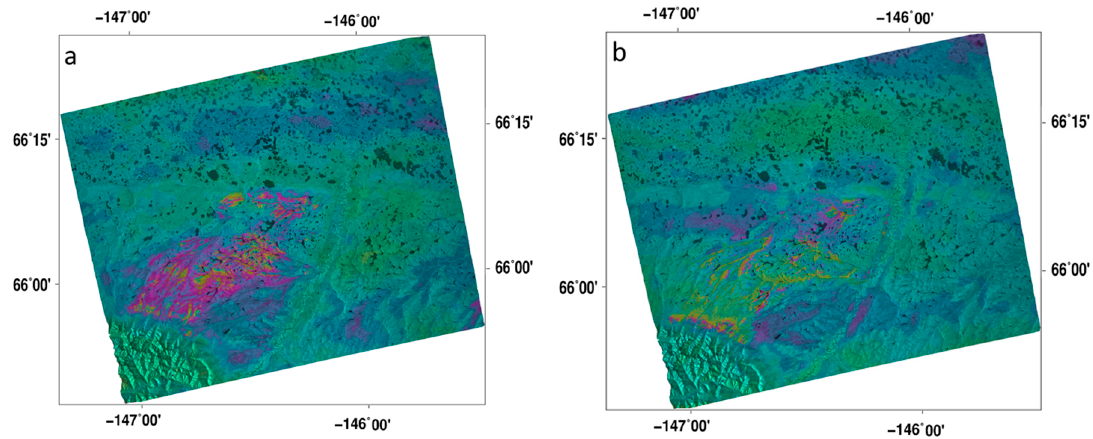
Figure 3. Temporal and perpendicular baselines of interferograms for paths 251 and 252.